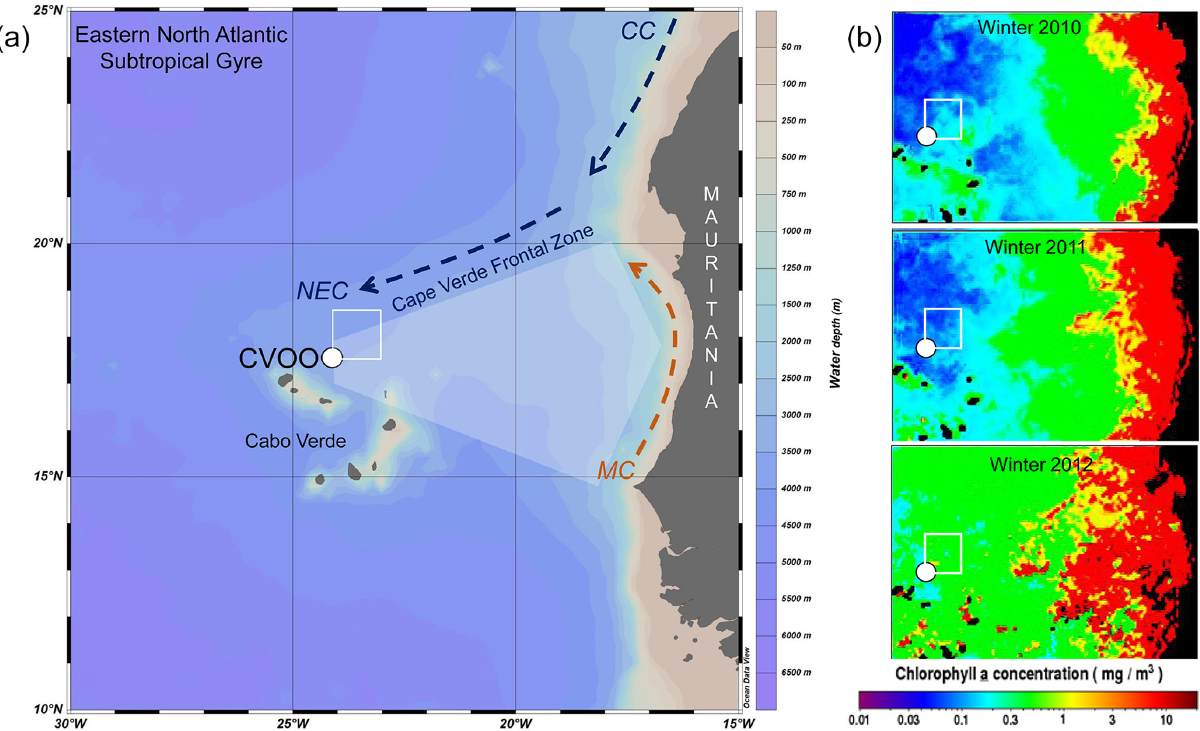
Figure 1. (a) Location of the CVOO site in the eastern tropical North Atlantic with the major current systems of the Canary Current (CC), the North Equatorial Current (NEC) and the Mauritanian Current (MC) (ODV map – Reiner Schlitzer, Ocean Data View, odv.awi.de, 2021, last access: 26 August 2020). Note the corridor of eddy passages from the African coast to CVOO schematically indicated as a light polygon. A white box with the environmental data from Giovanni is shown NE of CVOO. (b) Winter MODIS satellite chlorophyll (DJFM) between the African coast and the Cabo Verde islands (the CVOO site is shown by a white dot) for winters 2010, 2011 and 2012 (2016 is comparable to 2012, not shown), showing the increasing extensions of the high-chlorophyll area ( > 1mgm − 3 ) from the coast to the open ocean, approaching